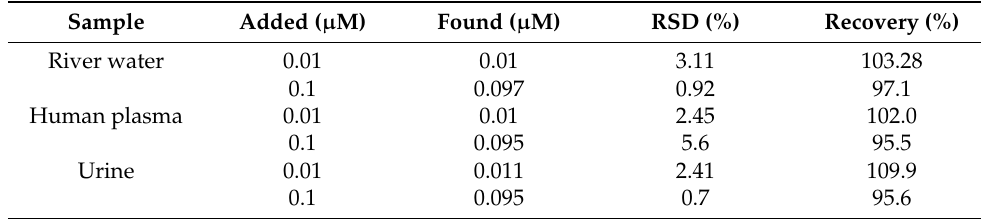
Table 2. Real samples analysis of FAV.